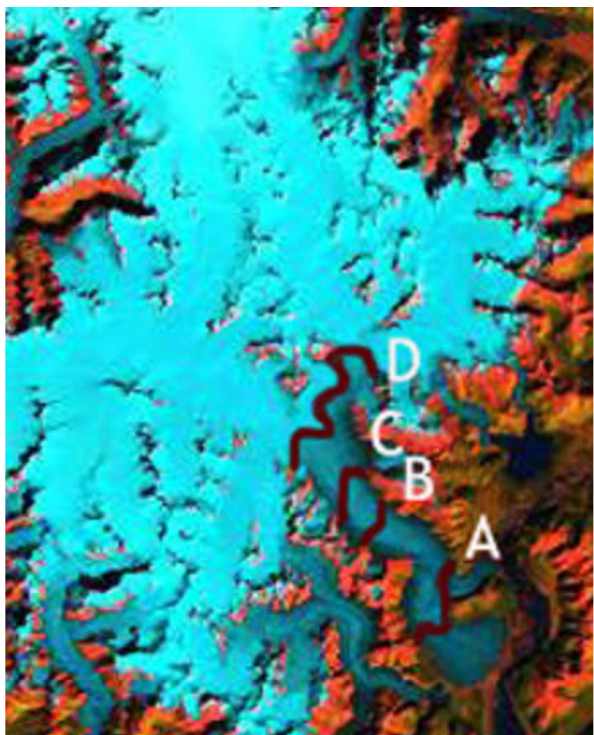
Fig. 6. TSL identification on Taku Glacier in 2006 Landsat image from 14 Semptember 2006. A=26 May 2006, B=5 July 2006, C=28 July 2006, D=14 September 2006.